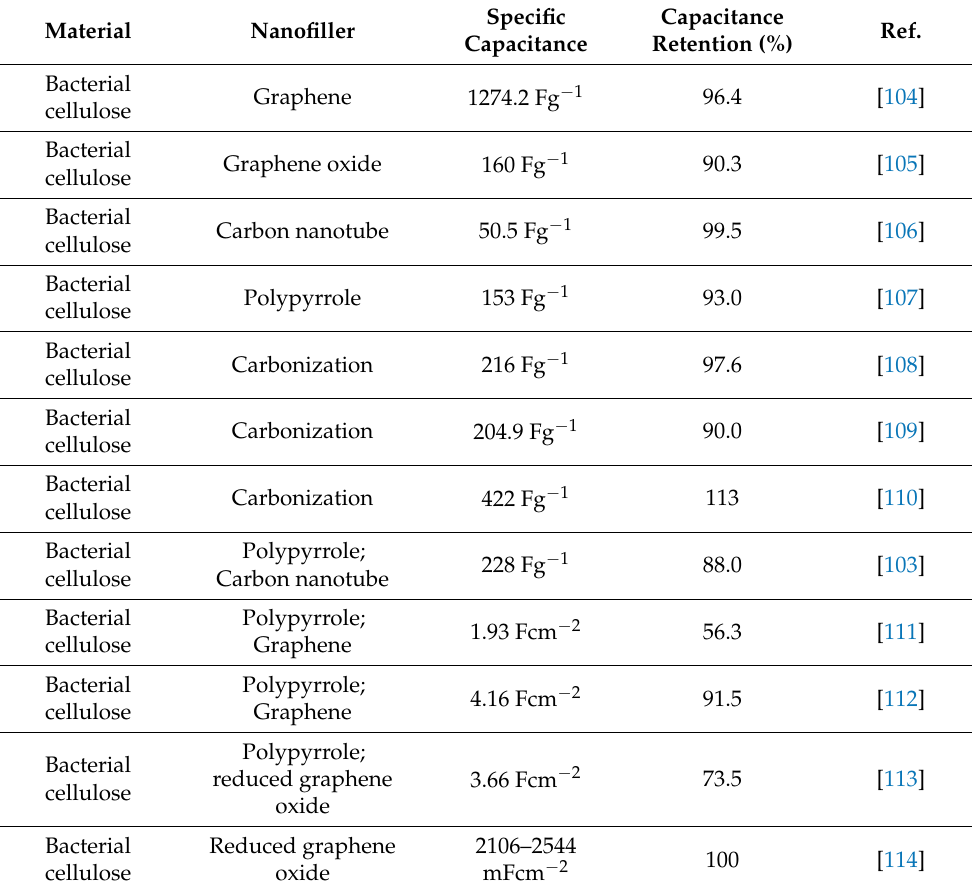
Table 2. Electrochemical performance comparison of bacterial cellulose electrode/nanocarbon for a